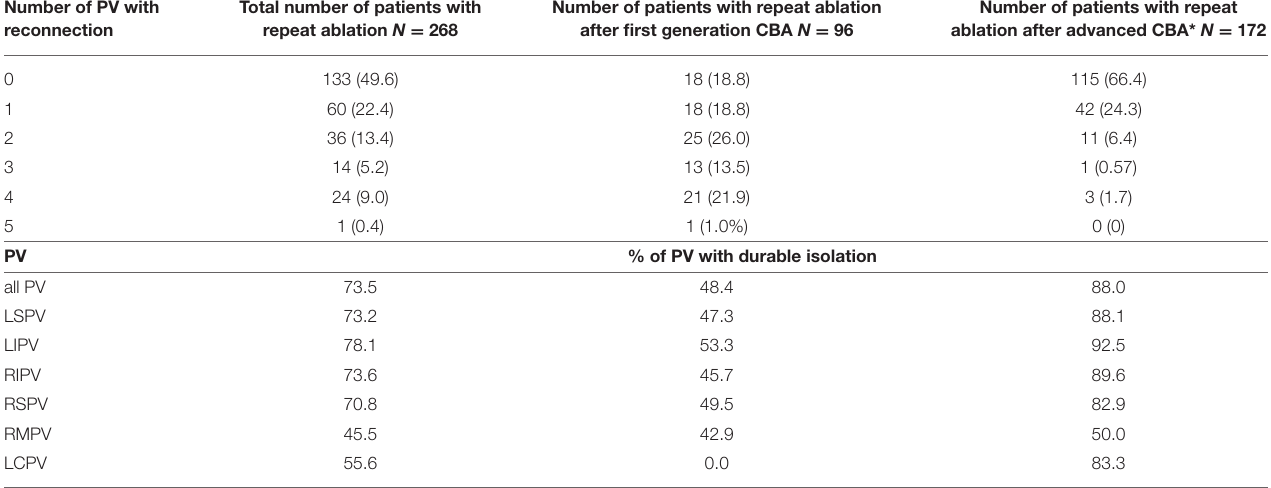
TABLE 5 | Pulmonary vein electrical reconnection at repeat ablation. Number of PV with Total number of patients with reconnection repeat ablation N =